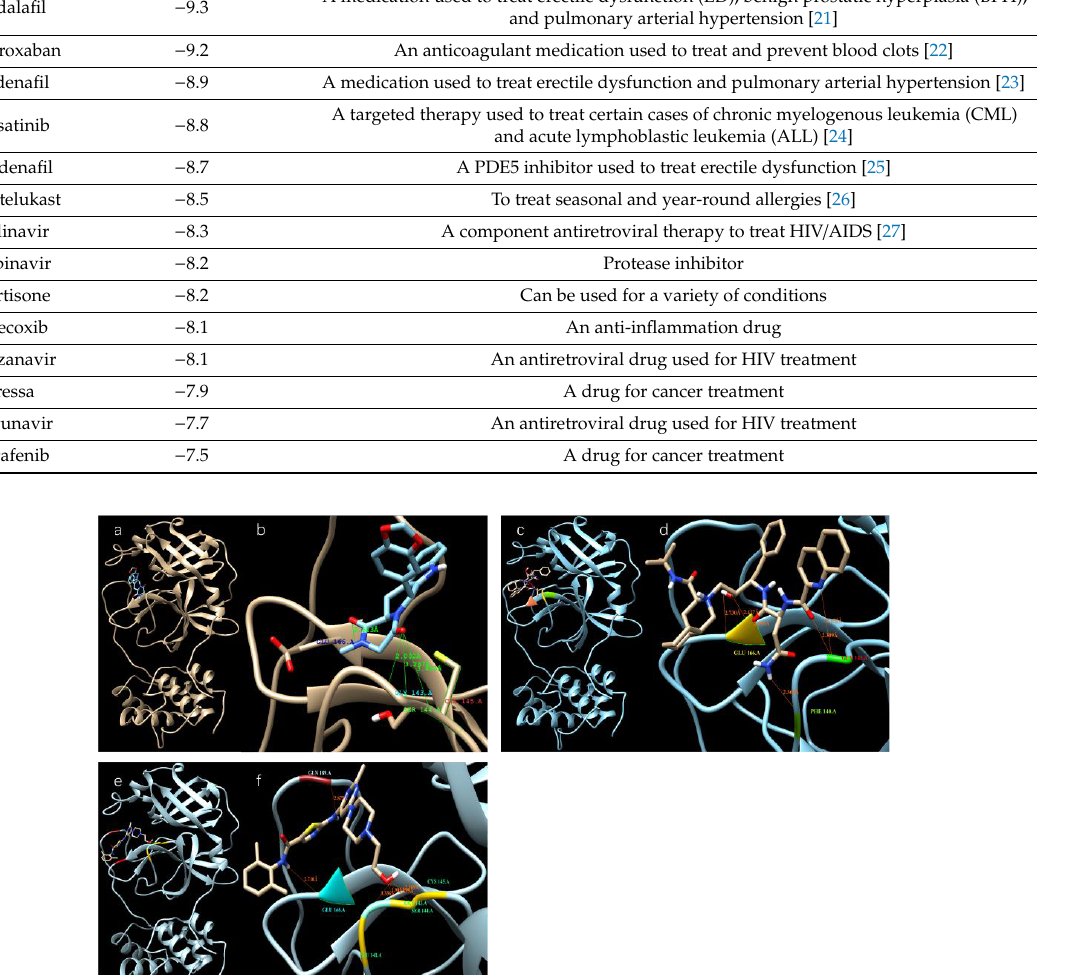
Table 1. Different docking scores (binding affinities) of the tested drugs for SARS-CoV-2 proteinase.